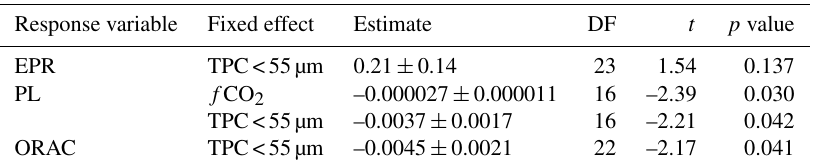
Table 2. T-statistics of the retained fixed effects in the linear mixed effect models testing the effects of TPC (<55µm), C:N and f CO 2 on EPR, female PL and female ORAC. Repeated measures of same mesocosm bags were used as a random effect in all the models, because copepods that come from the same bags are more alike than copepods from different